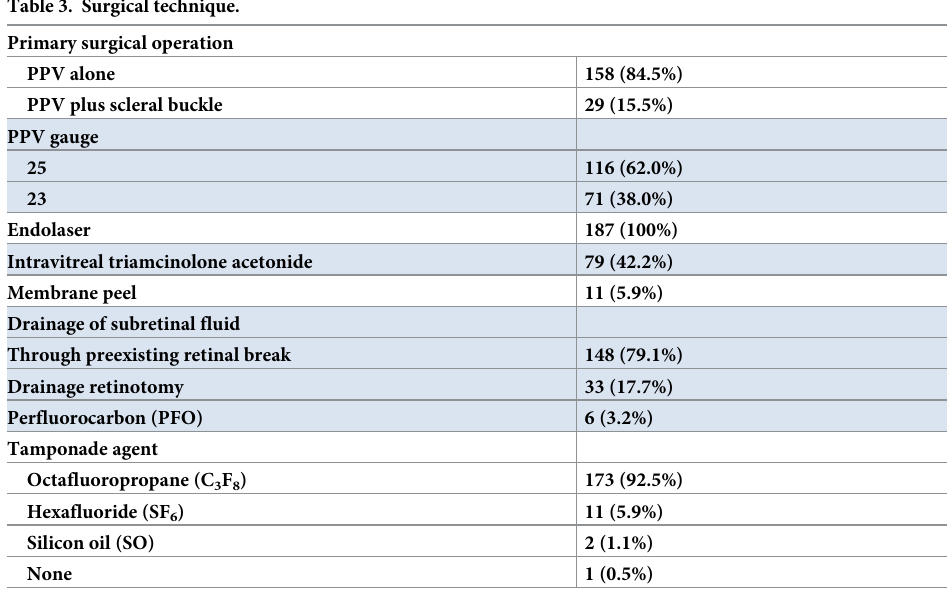
Table 3. Surgical technique.